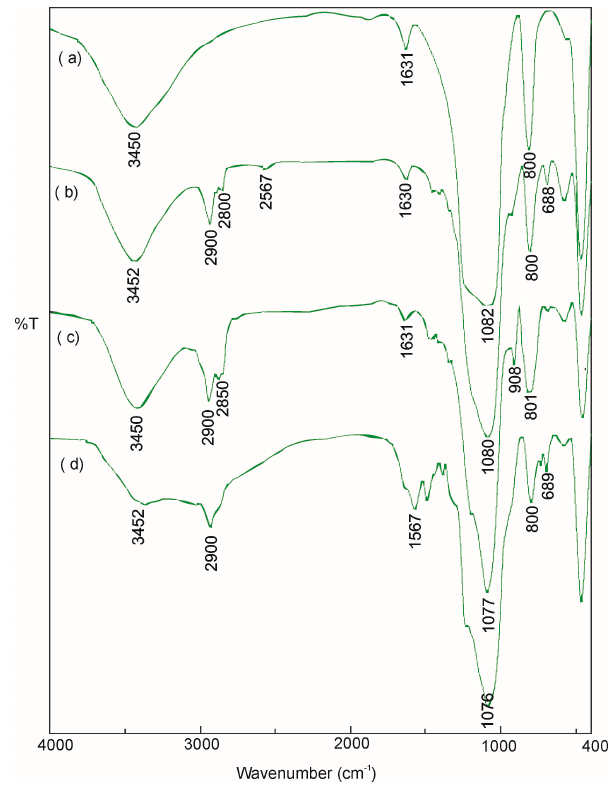
Figure 2. FTIR spectra of ( a ) MCM-41, ( b ) MCM-NH 2 , ( c ) MCM-SH, and ( d ) MCM-epoxy.